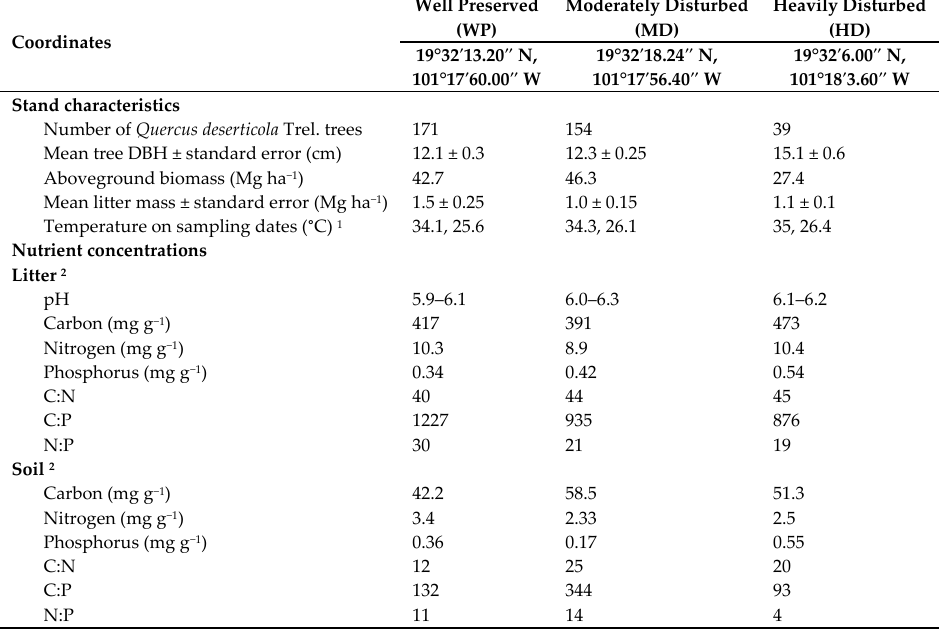
Table 1. Characteristics of the three forest sites with increasing levels of disturbance in central Mexico studied to examine fungal communities and ligninolytic enzyme activities.